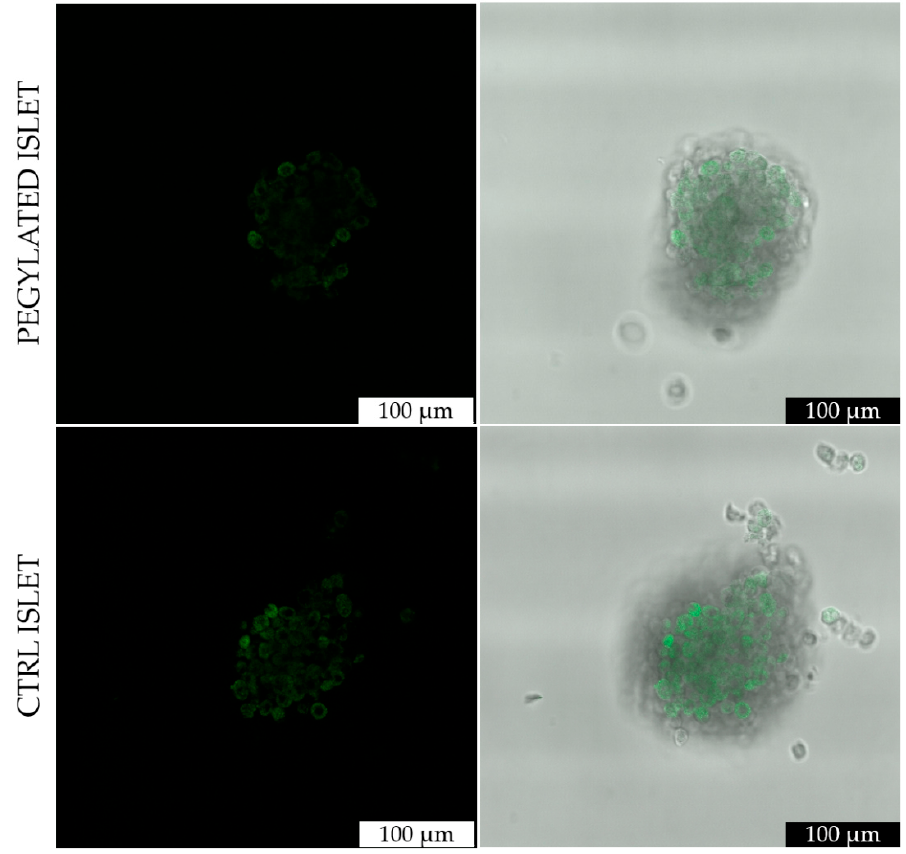
Figure 10. Confocal microscopy images of viable PEGYLATED (upper panels) and CTRL (lower panels) islets. The viability was qualitatively detected with the fluorescein diacetate (FDA) versus propidium iodide (PI) staining method 24 h post functionalization. Scale bar = 100 μ m.